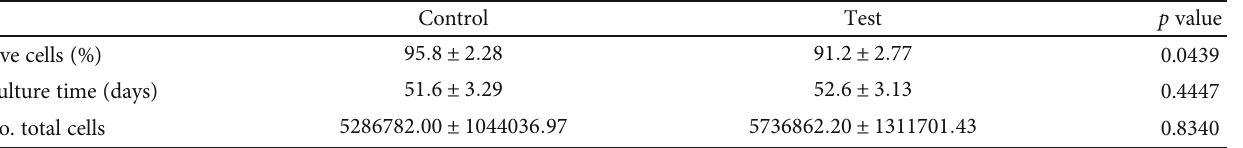
Table 1: Results for % of live cells, culture time, and total cells for the studied groups.